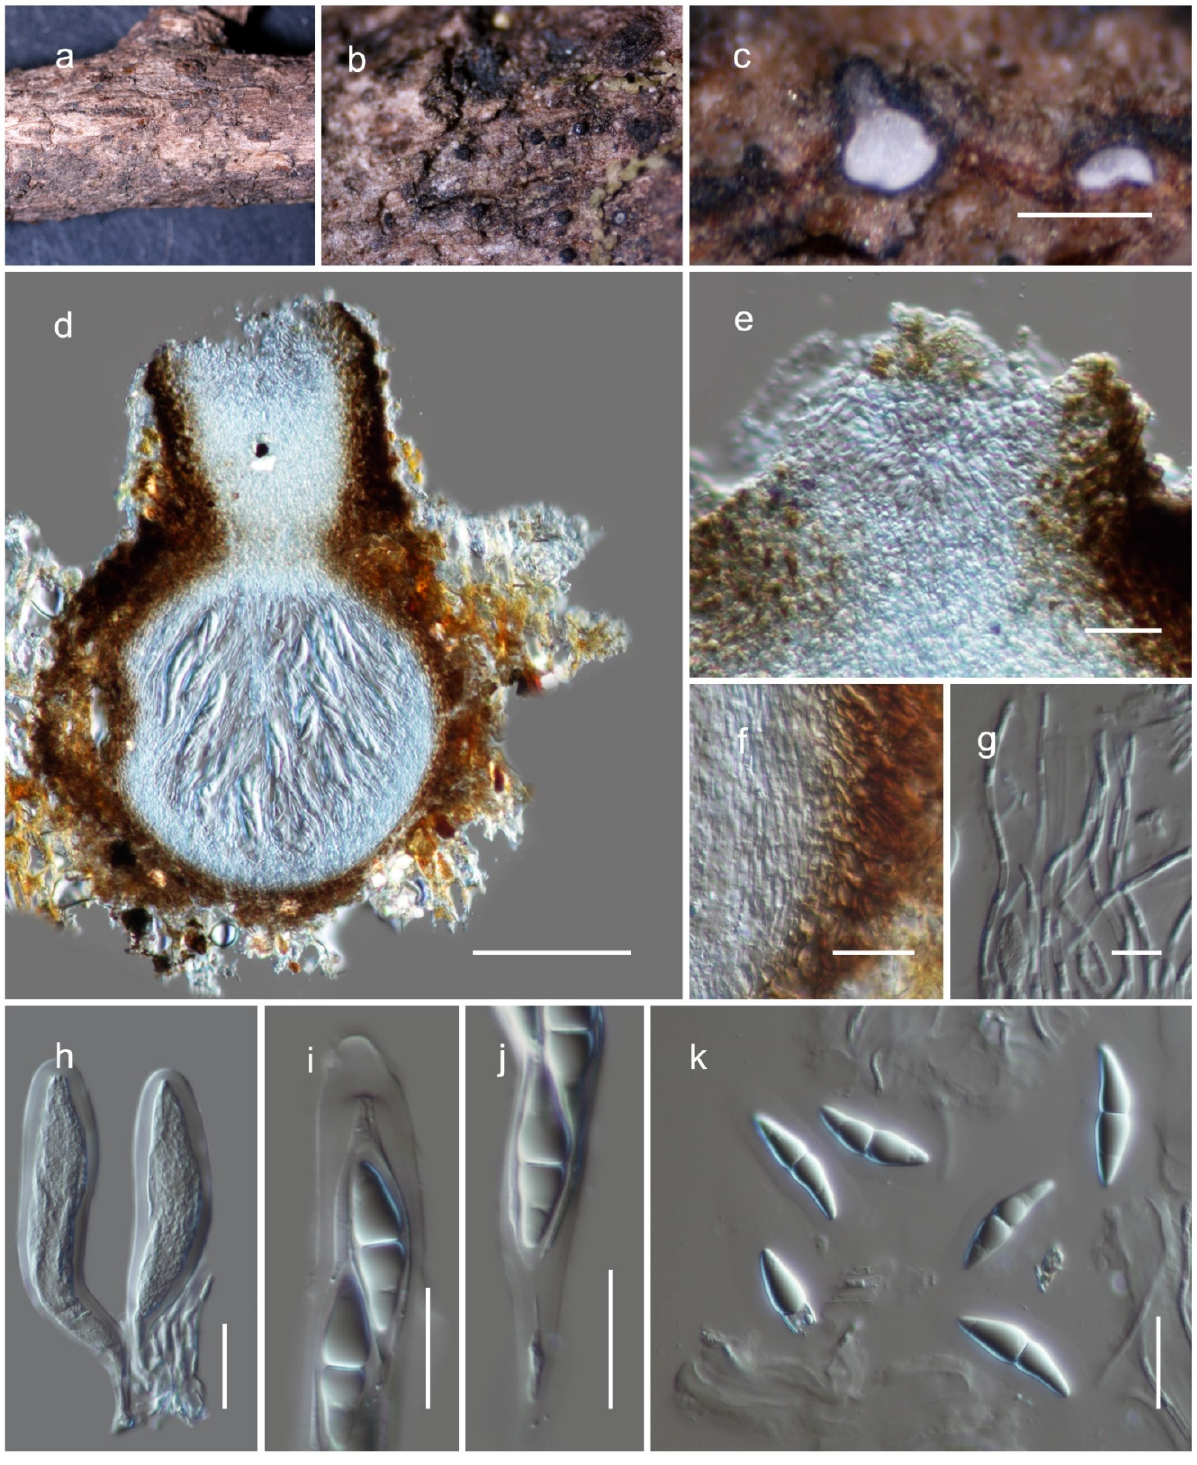
Figure 4. The teleomorph of Kazuakitanaka yuxiensis (HKAS122924, holotype). ( a , b ) Ascomata on dead woody twigs; ( c , d ) vertical section of ascomata; ( e ) closeup of ostiole; ( f ) peridium; ( g ) pseudoparaphyses; ( h – j ) asci; ( k ) ascospores. Scale bars: ( c ) 500 μ m; ( d ) 100 μ m; ( e , f , h – k ) 20 μ m; ( g ) 10 μ m. Kazuakitanaka lancangensis Wanas. sp. nov. (Figure 5).